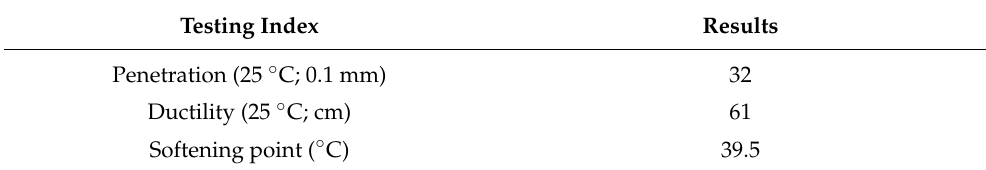
Table 2. Testing results of recycled asphalt from RAP.